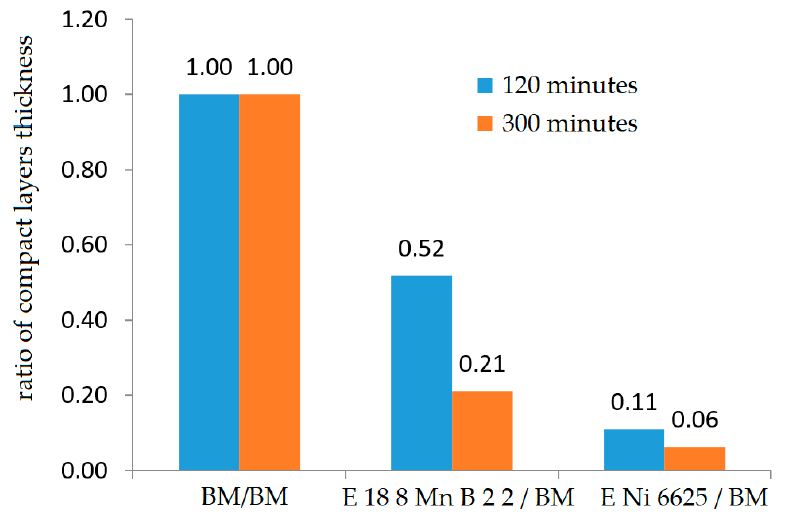
Figure 27. Relative corrosion resistance of welded clads to the base material.